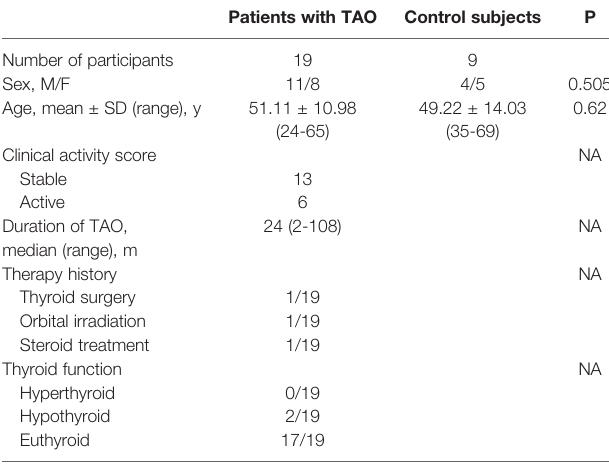
TABLE 2 | Demographic Data of Patients with TAO and Controls undergoing